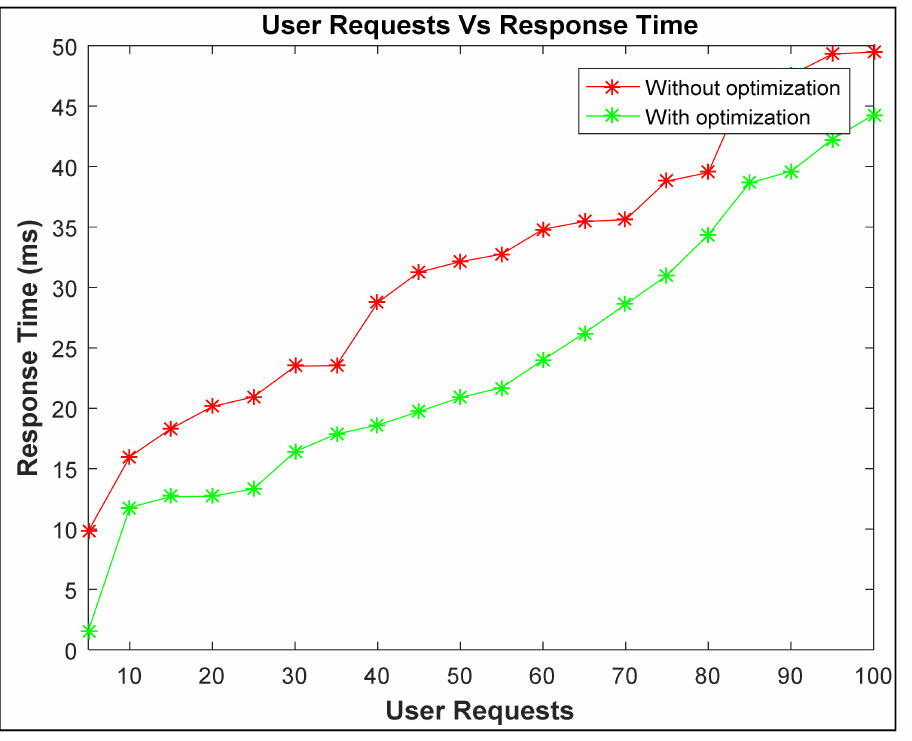
Figure 11. Response Time.